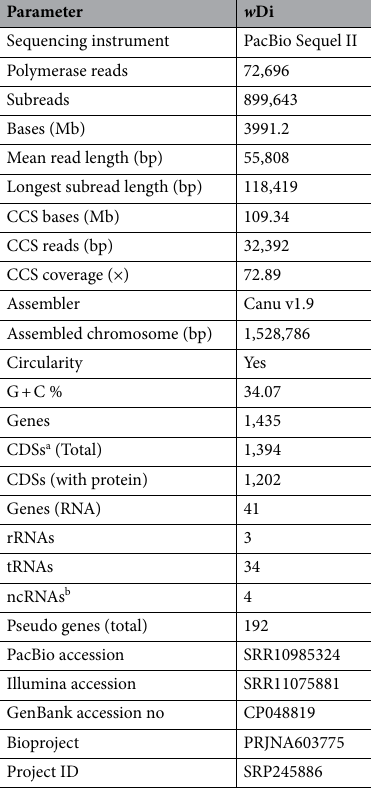
Table 1. Assembly statistics of w Di genome assembly. a CDSs, coding DNA sequences. b ncRNAs, noncoding